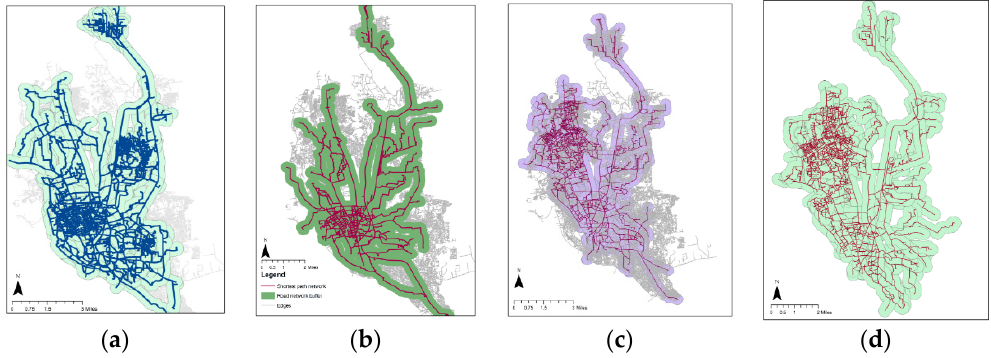
Figure 9. Aggregate activity space ( a ) Dhanmondi weekday, ( b ) Dhanmondi weekend, ( c ) Mirpur weekday, and ( d ) Mirpur weekend (a comparative illustration).